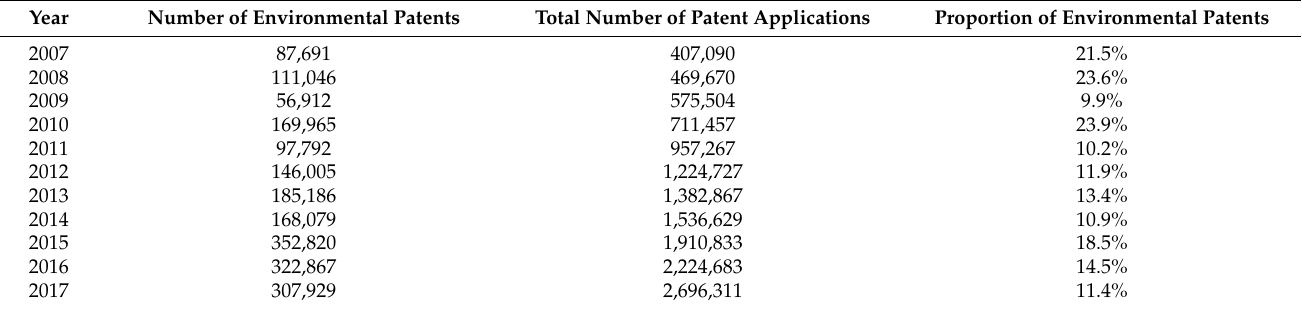
Table 2. Proportion of environmental patents in overall patents from 2007 to 2017 in